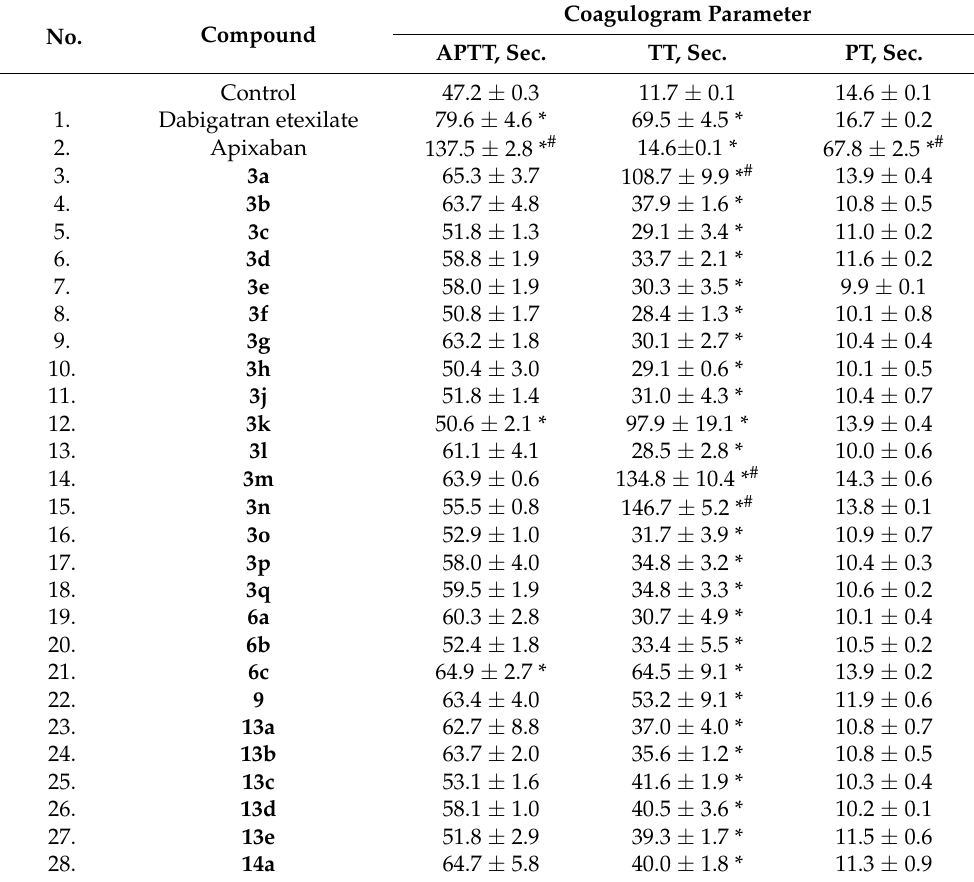
Table 1. Effect of derivatives of azolo[1,5- a ]pyrimidines and their condensed analogs on the pa- rameters of the coagulogram of rabbit blood in vitro at a concentration of 100 µ M (M ± m, n = 5). APTT—activated partial thromboplastin time; TT—thrombin time; PT—prothrombin time. No. Compound APTT,